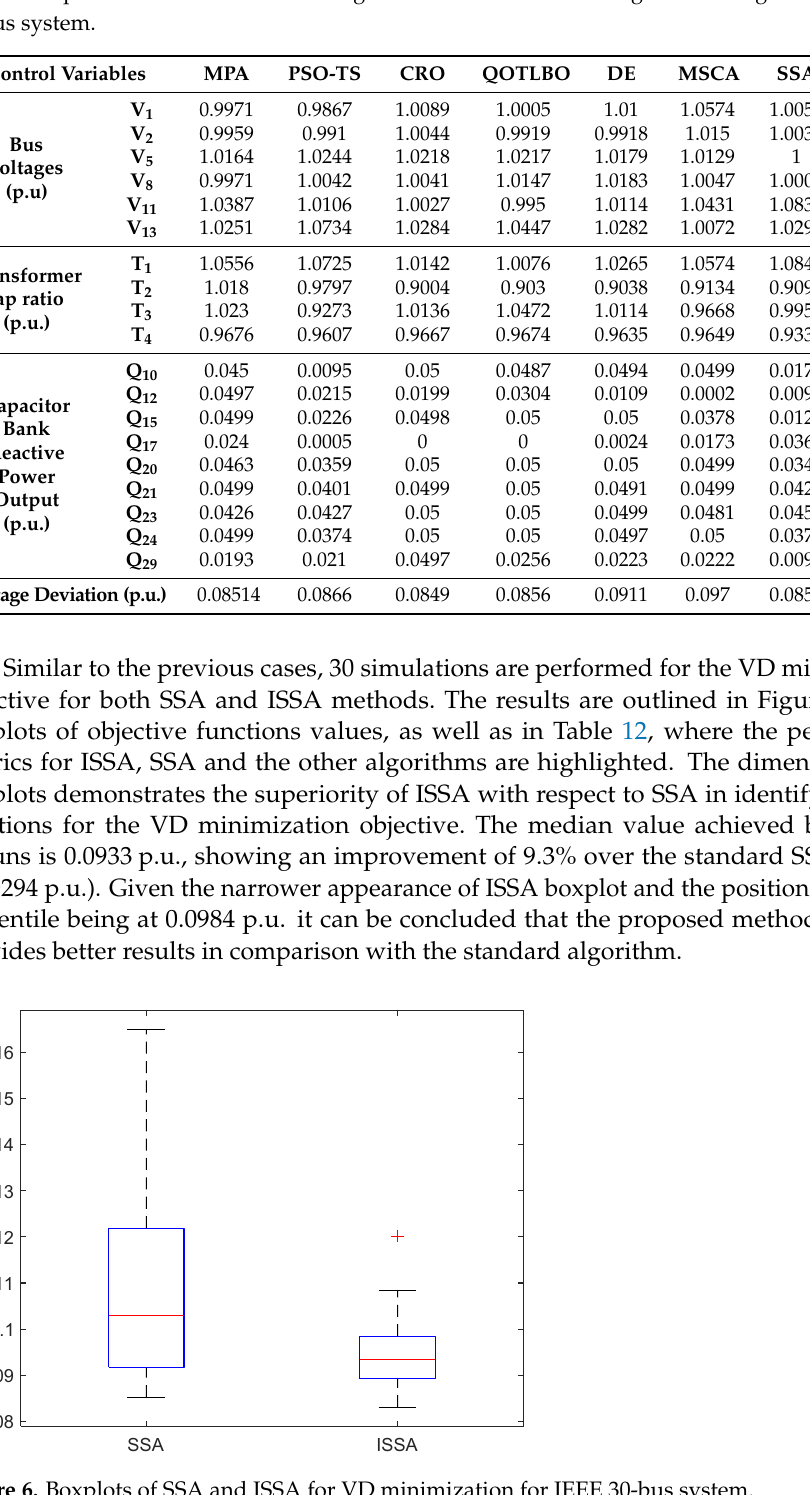
Figure 6. Boxplots of SSA and ISSA for VD minimization for IEEE 30-bus system. Table 12. Statistical c omparison of results for voltage deviation minimization for IEEE 30-bus system.